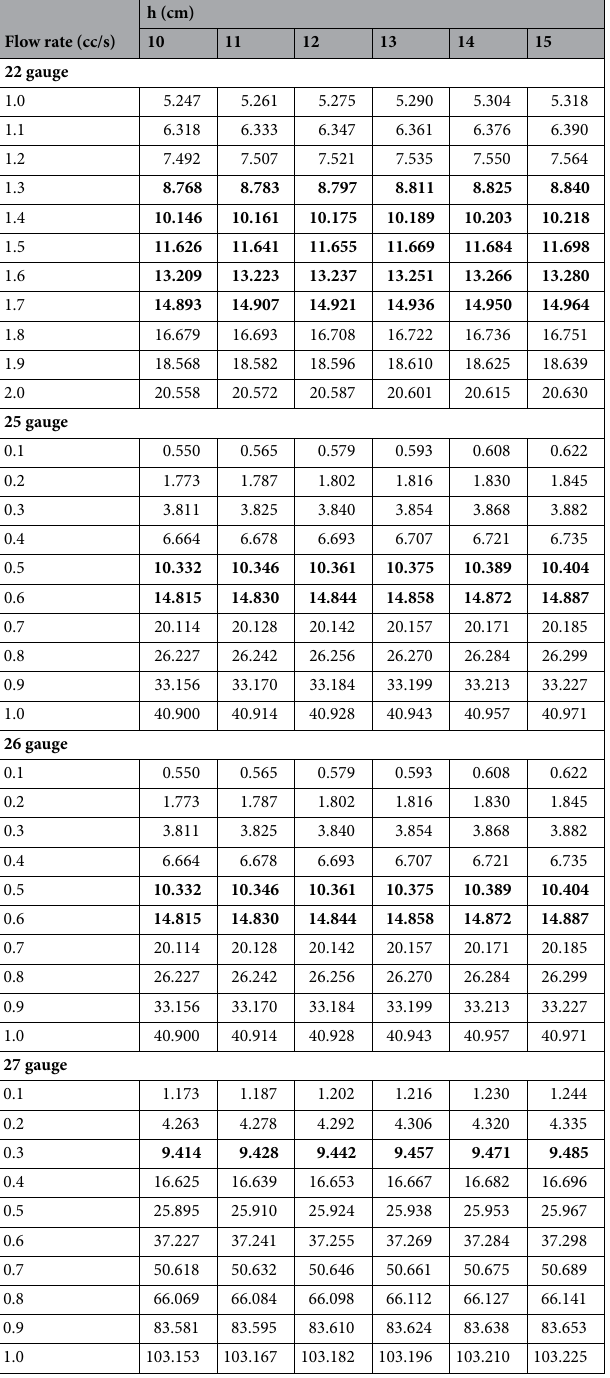
Table 3. Flow rate analysis according to the height from the wound of 22–27 gauge. Significant values are in